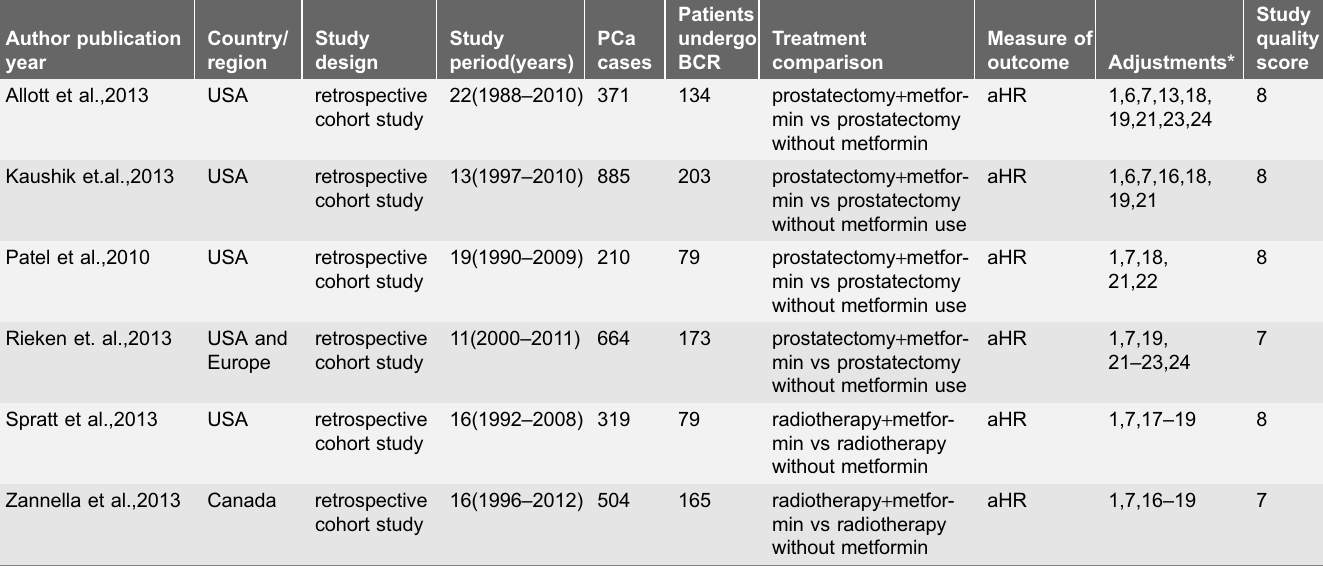
Table 2. Characteristics of the included studies for the BCR of prostate cancer analysis.